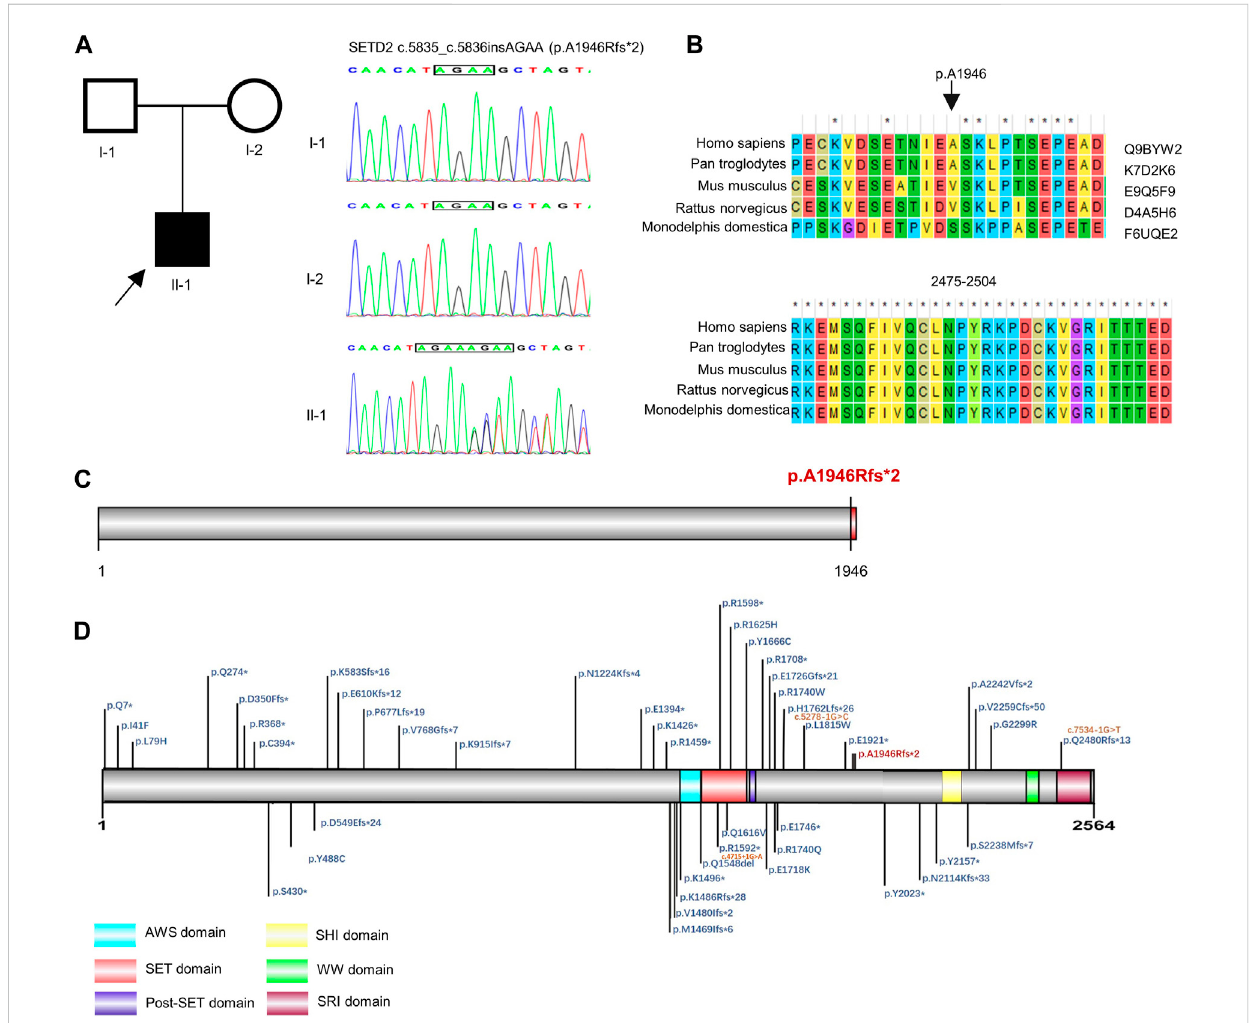
FIGURE 2 Visualization and structural analysis of SETD2 protein. The cartoon model (A) and surface electrostatic charge model (B) of SETD2 protein (AF- Q9BYW2-F1). The blue part represented the amino acid residues after the1946th site. The yellow part represented the 1946th amino acid residue, which thewhitearrowpointedto. (C) CrystalstructureofhnRNPLincomplexwithSETD2(PDB:7EVR).Theorangelinestood fortheSHIdomain(2167 – 2192aa) from SETD2. (D) Alignment of SHI domains from AF-Q9BYW2-F1 and 7EVR. The red line represented the SHI domain from